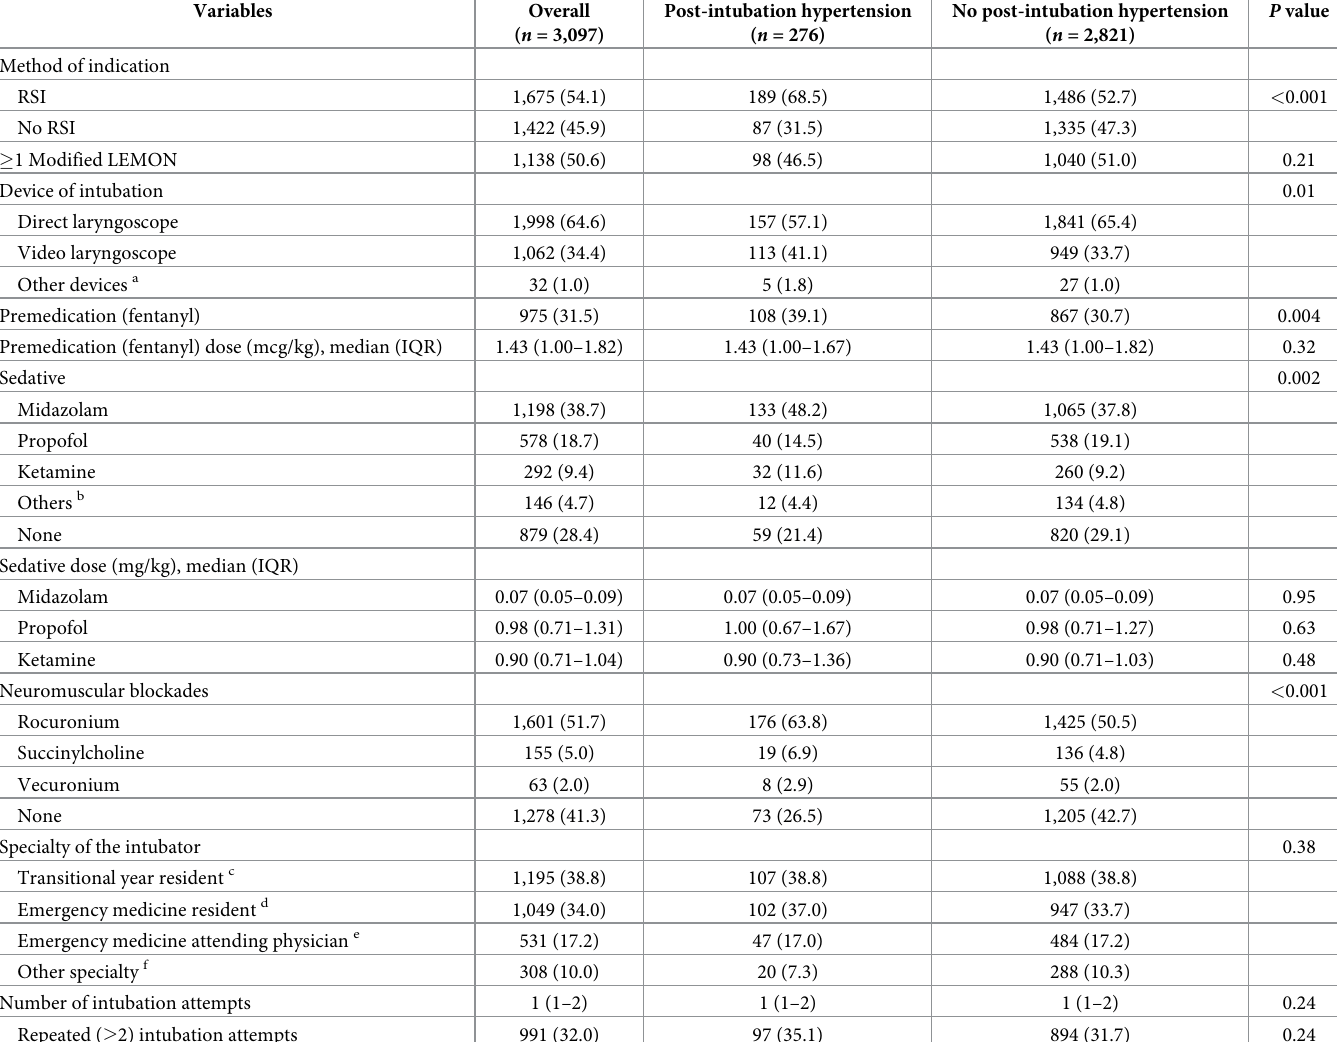
Table 2. Airway management characteristics of the study population, according to the